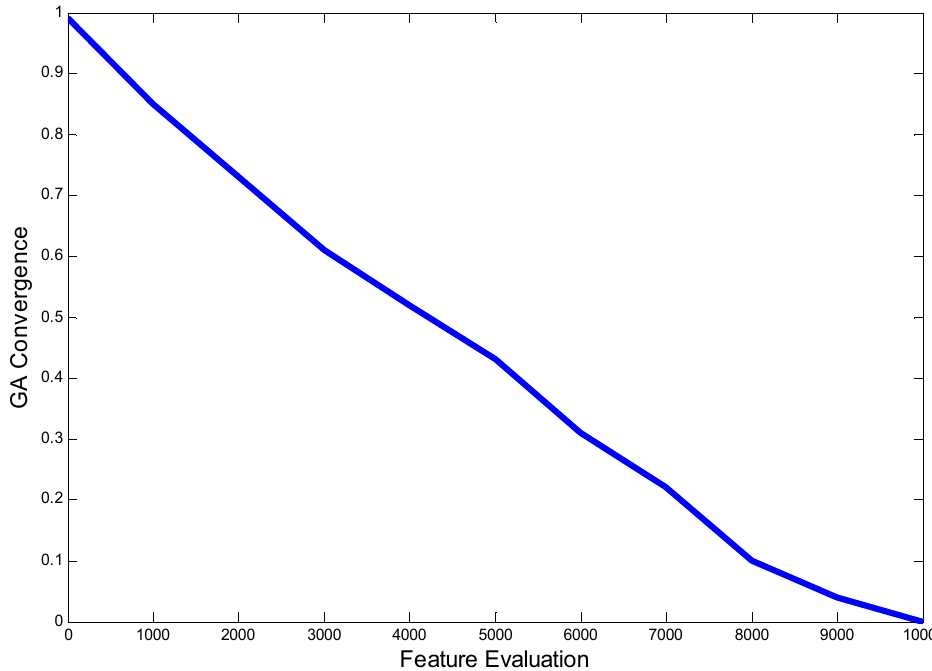
Figure 5. Convergence characteristic for the genetic algorithm (GA) showing the variation of particles with respect to the global optimum.